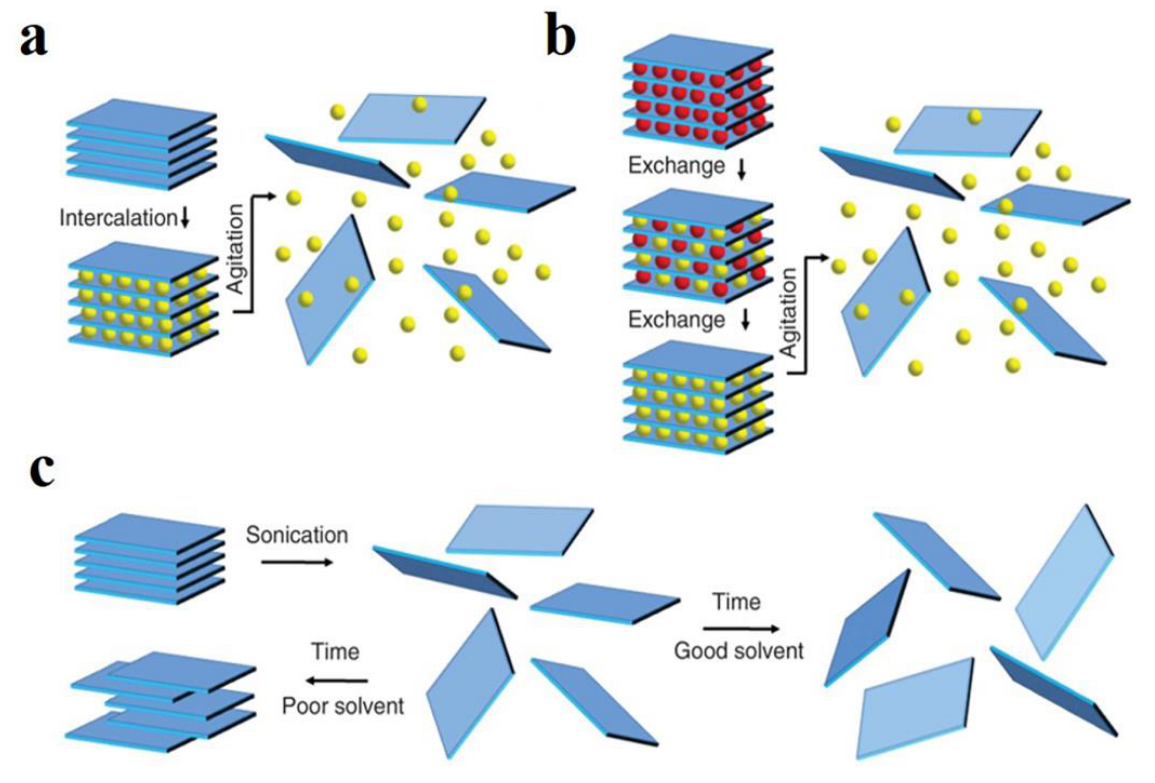
Figure 4. ( a ) Intercalation; ( b ) Ion exchange; ( c ) Sonication-aided exfoliation.